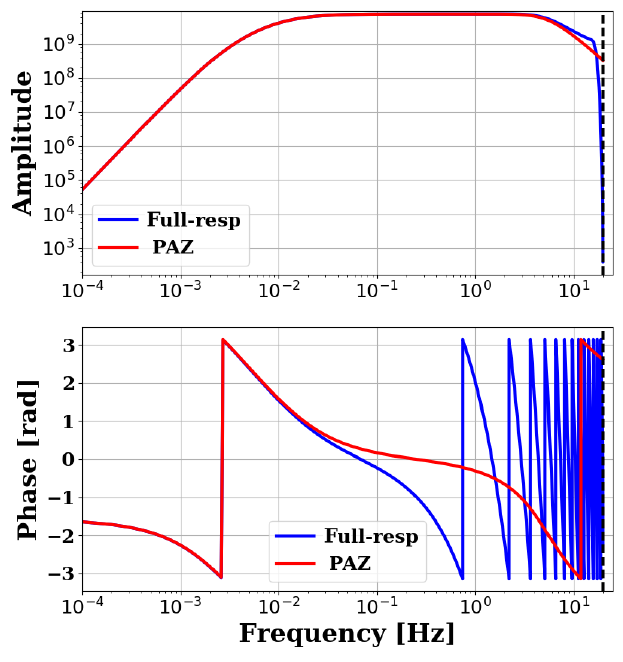
Figure 7. obspyDMT --plot_stationxml --plotxml_paz --plotxml_min_freq 0.0001 --datapath /path/to/STXML.GT.LBTB.00.BHZ Transfer function spectra (amplitude and phase) of a Geotech KS-54000 borehole seismometer (GT.LBTB) in Botswana. Blue lines show transfer function components computed for all filter stages in the StationXML file; red lines are for the analog part. A large discrepancy exists between the phase spectra of the two transfer functions. The deviation emerges at frequencies around 10 − 2 Hz and increases up to the Nyquist frequency. Fig. 8 shows that this difference is caused by one of the digital stages in the instrument